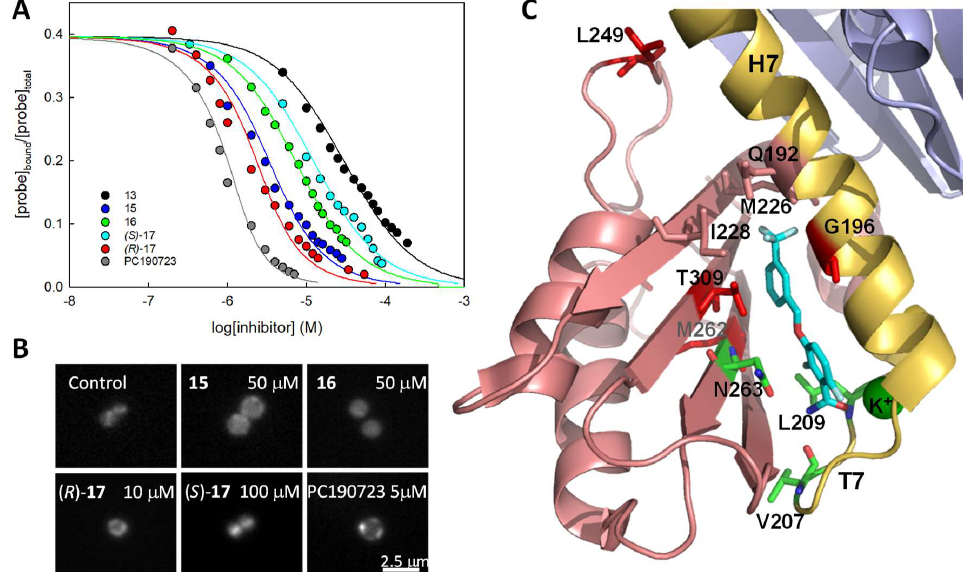
Figure 6. ( A ) Displacement curves of probe (R) - 10 (3 µ M) from stabilized BsFtsZ polymers (2.7 µ M binding sites) by synthetic allosteric inhibitors 13 (black), 15 (blue), 16 (green), (R) - 17 (red), (S) - 17 (cyan), and by PC190723 (gray). Lines correspond to the best-fitted competition curve in each case. ( B ) S. aureus cells expressing FtsZ-mCherry grown for 1.5 h in the absence (control) or presence of 15 , 16 , ( R )-, (S) - 17 , and PC190723, observed by fluorescence microscopy. Scale bar: 2.5 μm. ( C ) Scheme of the structure of the SaFtsZ- 15 complex around the inhibitor (cyan)binding cleft. The positions of the MRSA inhibitor resistance mutations analyzed, G196S, L249V, M262I, and T309I, are indicated by the wild type side chains (red). Indicated as well are residues V207, L209, and N263 (green) that establish hydrogen bonds with the amide group of 15 . The T309 side chain has rotated to lodge the trifluoromethylphenyl ring between T309 and G196. The side chains of M226, I228, and Q192 (salmon) form a pore connecting the binding site to the upper part of the cleft. A K + ion stabilizing loop T7 is also coordinated by the amide carbonyl of 15 . Not shown are additional residues